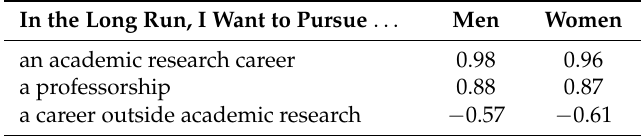
Table A2. Academic Career Intentions: Factor Loadings of CFA.